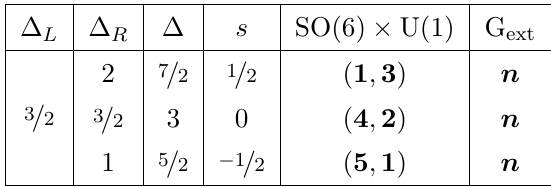
(cid:3) j 4) solution with chiral embedding (2.21a). The gauge SO(3) G ext (cid:2) (cid:2)